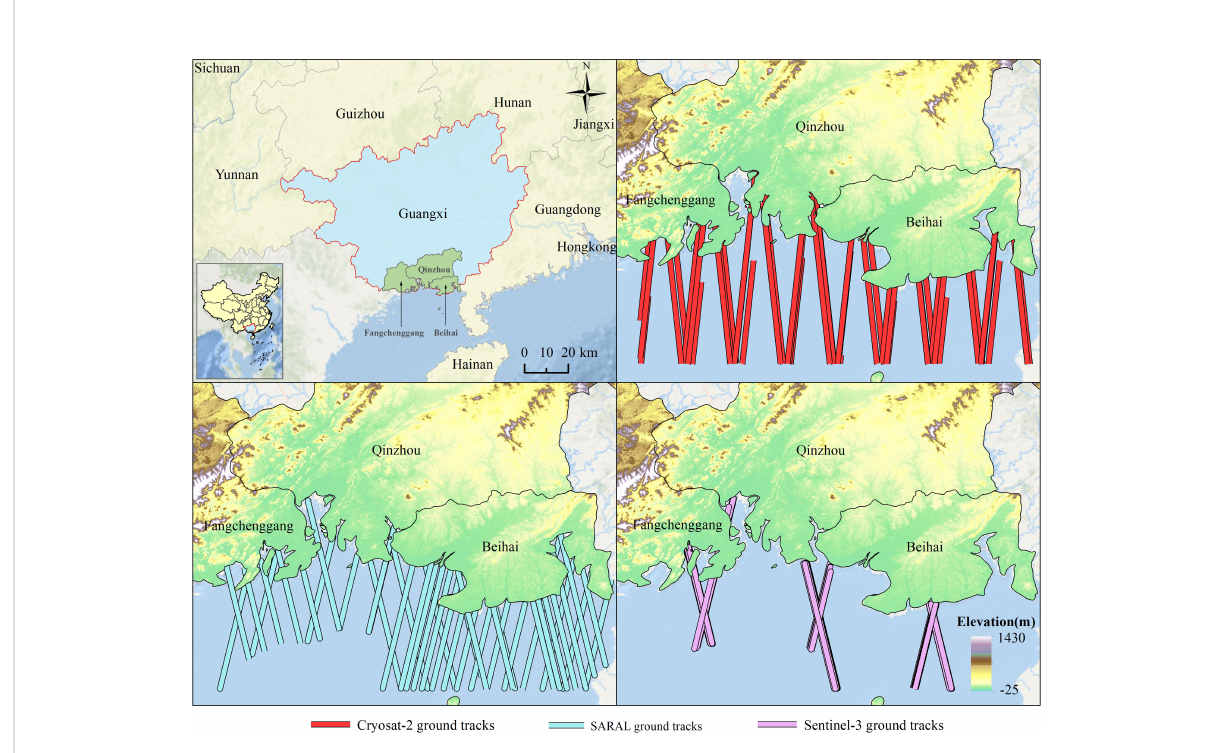
FIGURE 1 Geographical location of the study area and ground tracks of the three altimeters.